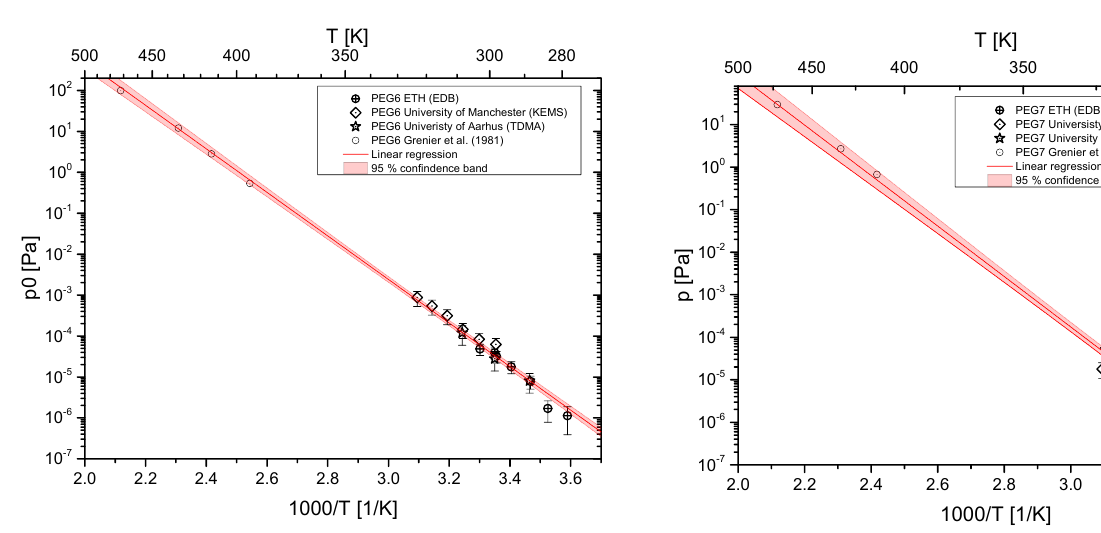
Figure 6. Saturation vapor pressures vs. temperature of heptaethy- lene glycol (PEG7). Symbols as in Fig.